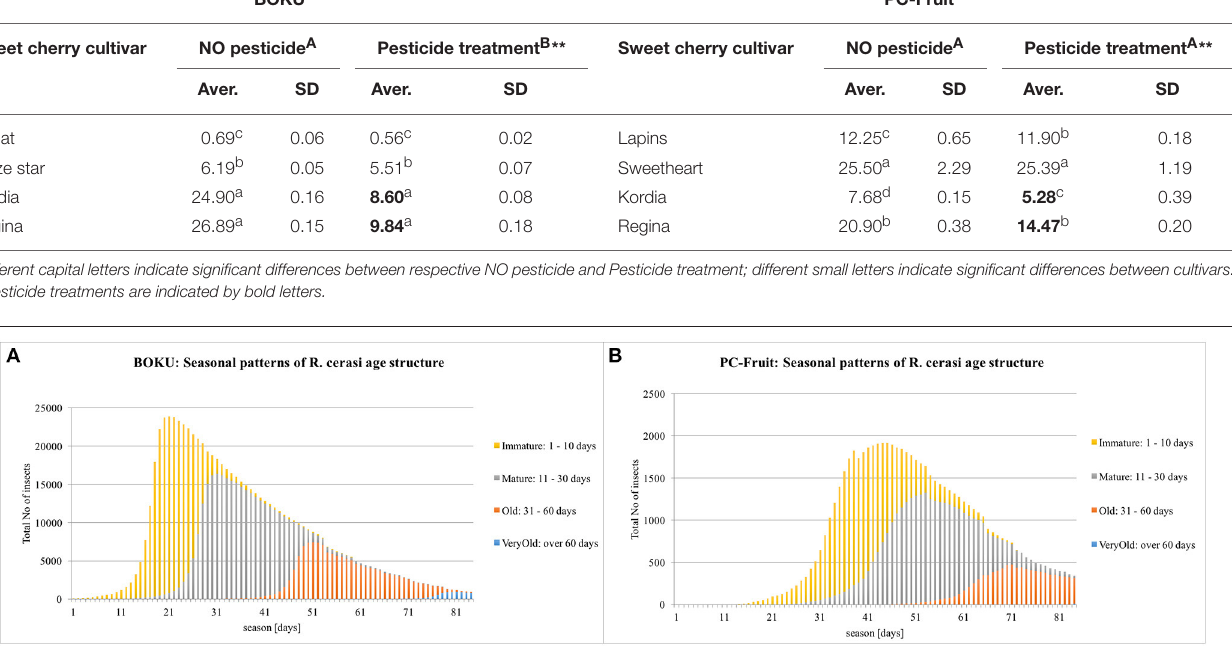
TABLE 5 | Influence of host phenology and IPM treatments on the effective net fecundity of R. cerasi females. Net effective fecundity/female emerging from the soil in spring* BOKU PC-Fruit Sweet cherry cultivar